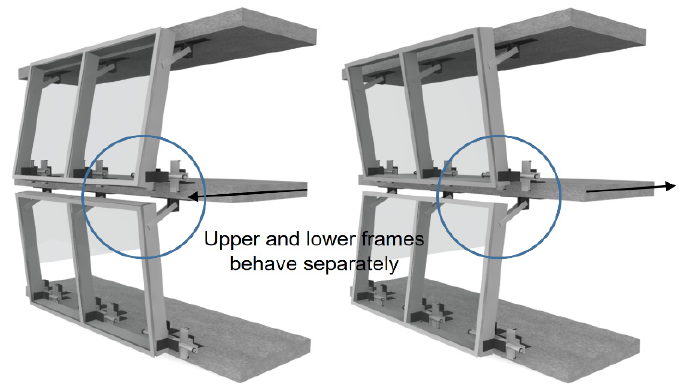
Figure 8. Displacement absorbing principle of the inter-story separated module.